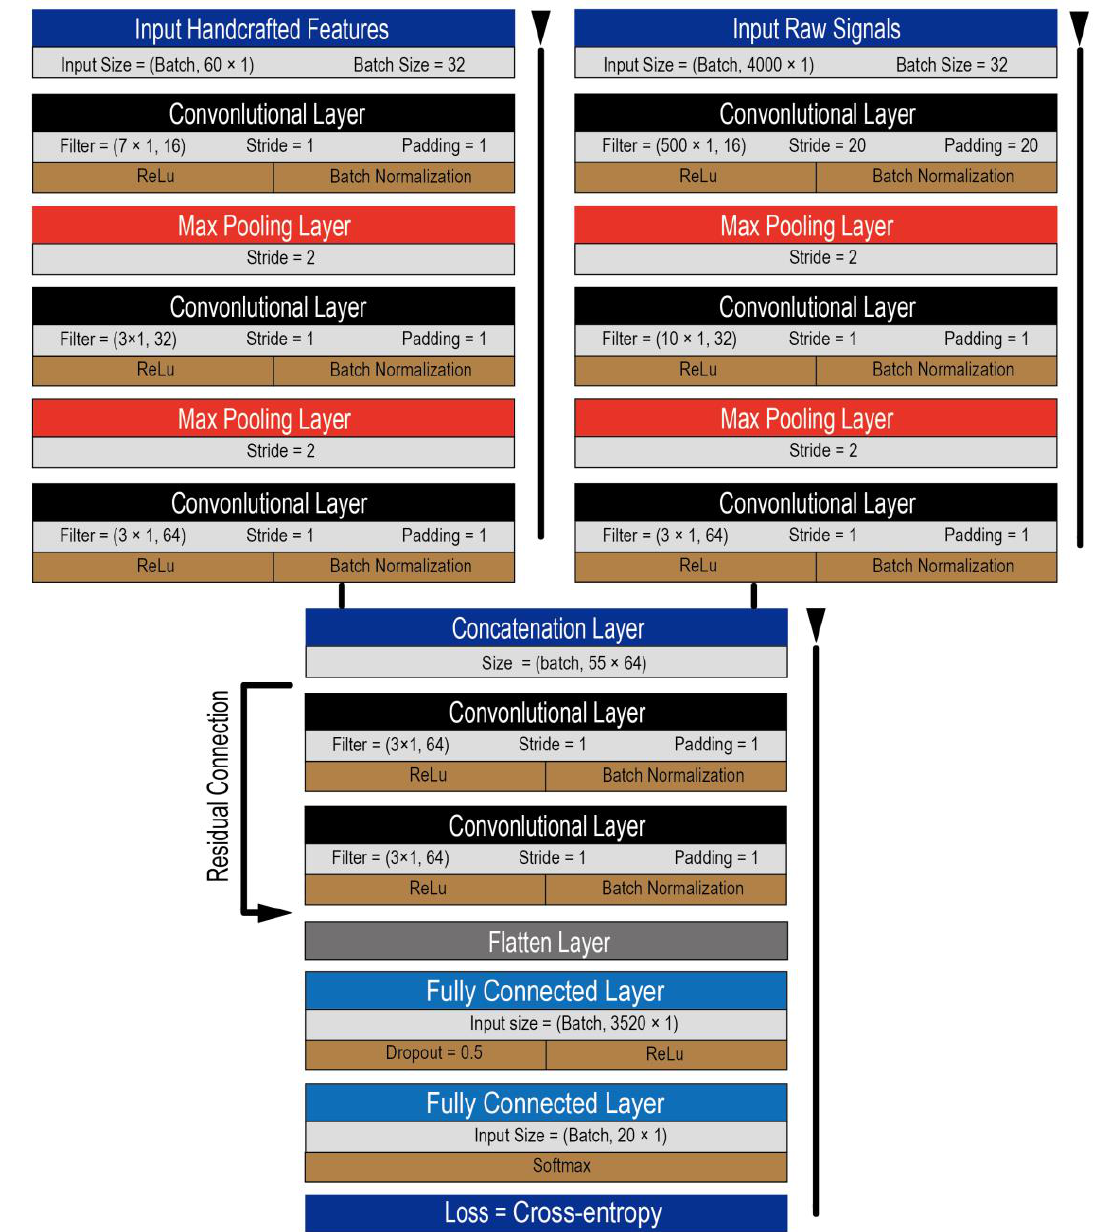
Figure 6. The architecture and layer configuration for the reference PCNN model. Hyperparameters in the feature engineering and extraction stages have been optimized based on the reference models in Figure 5a and Figure 5b, respectively. The black triangles indicate the direction of the convolution